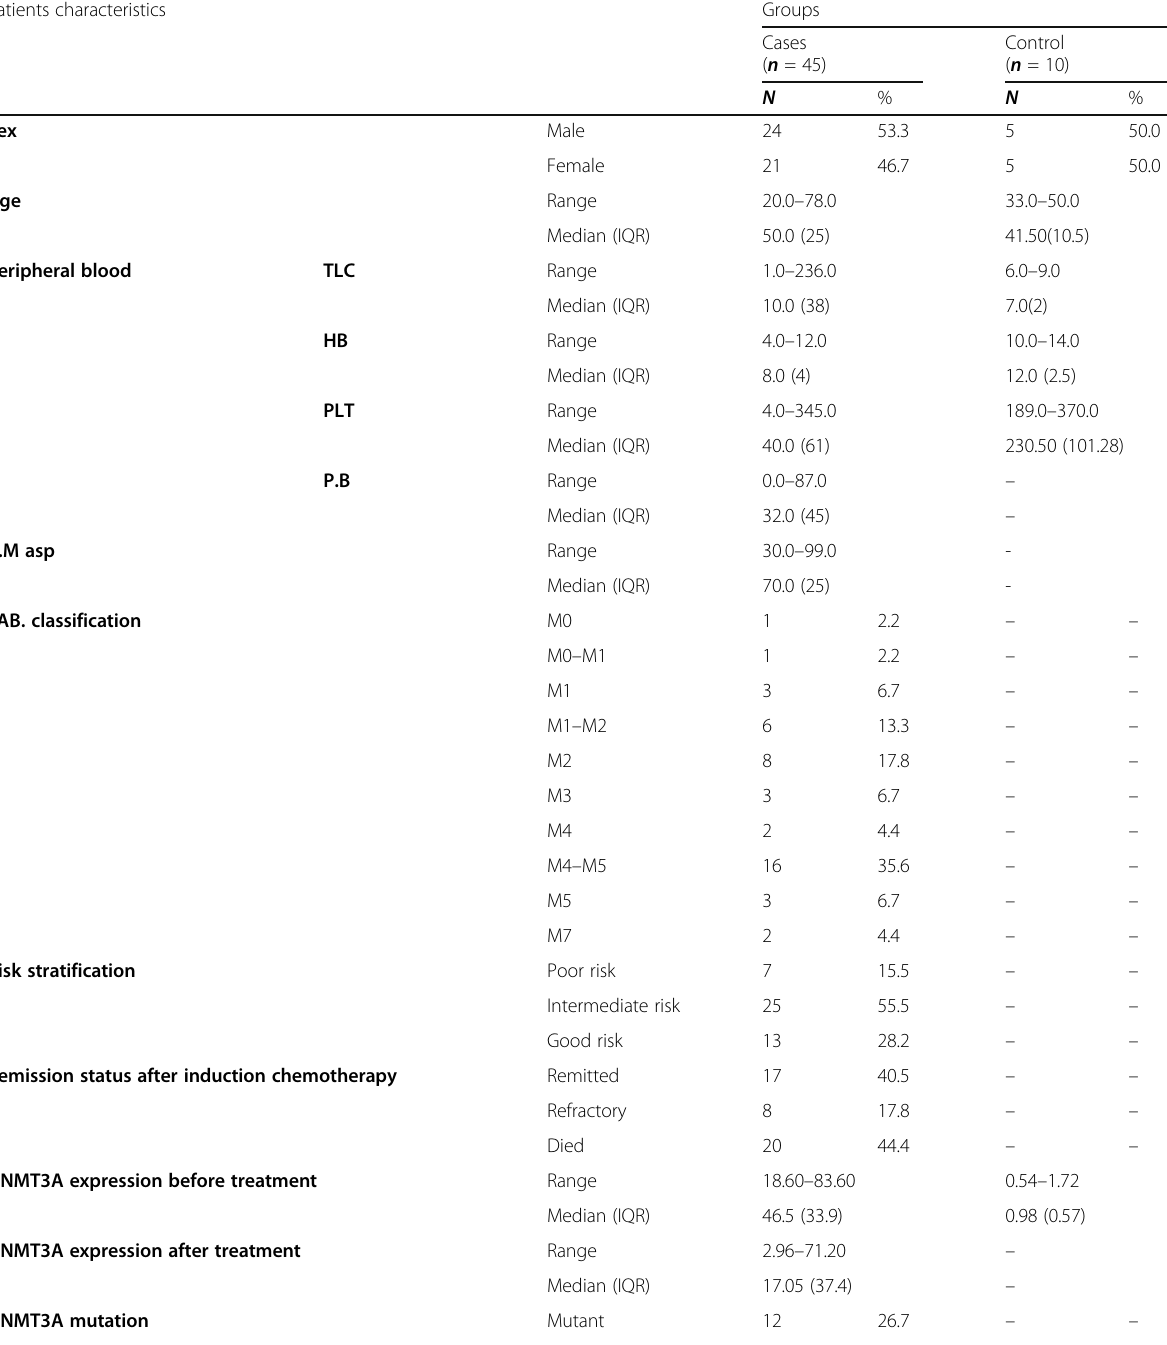
Table 1 Demographic data and patient characteristics Patients